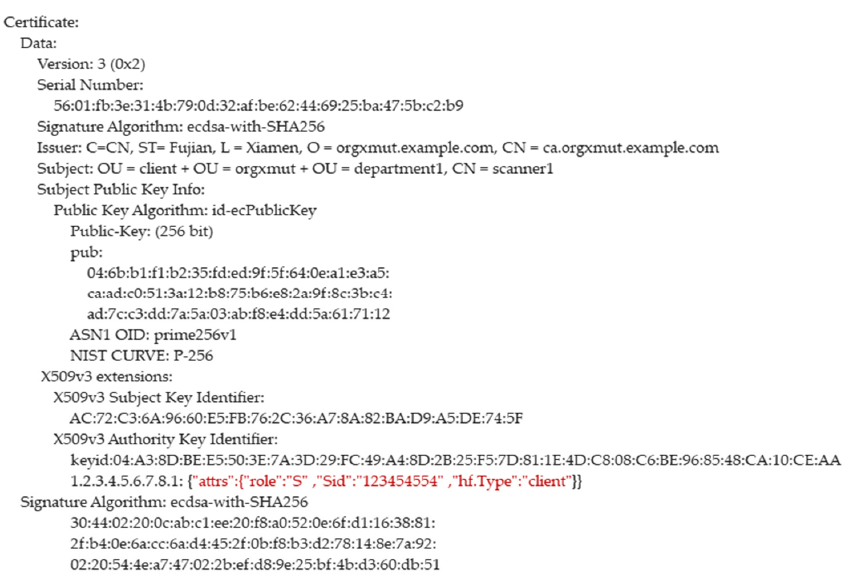
Figure 3. The example of the scanner device digital certificate.